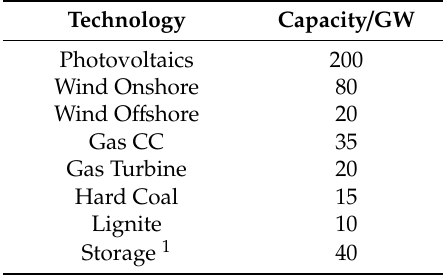
Table A2. Scenario parameters for the technologies in the extended storage scenario.